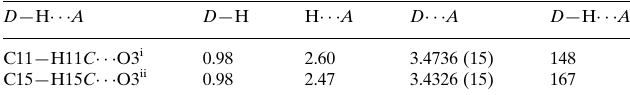
Hydrogen-bond geometry (A˚ , (cid:2)